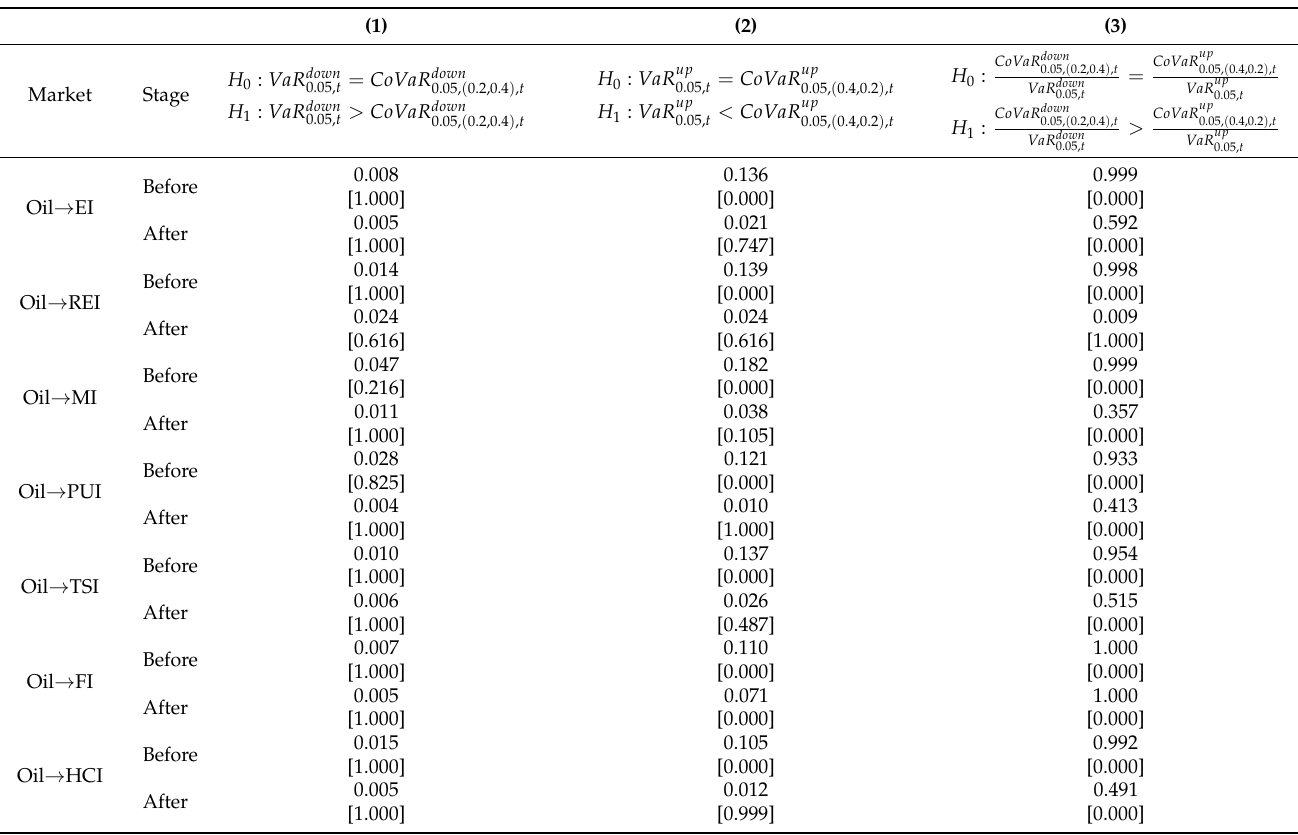
Table 9. Hypothesis testing for risk spillover of moderate oil market on Chinese sectoral stock